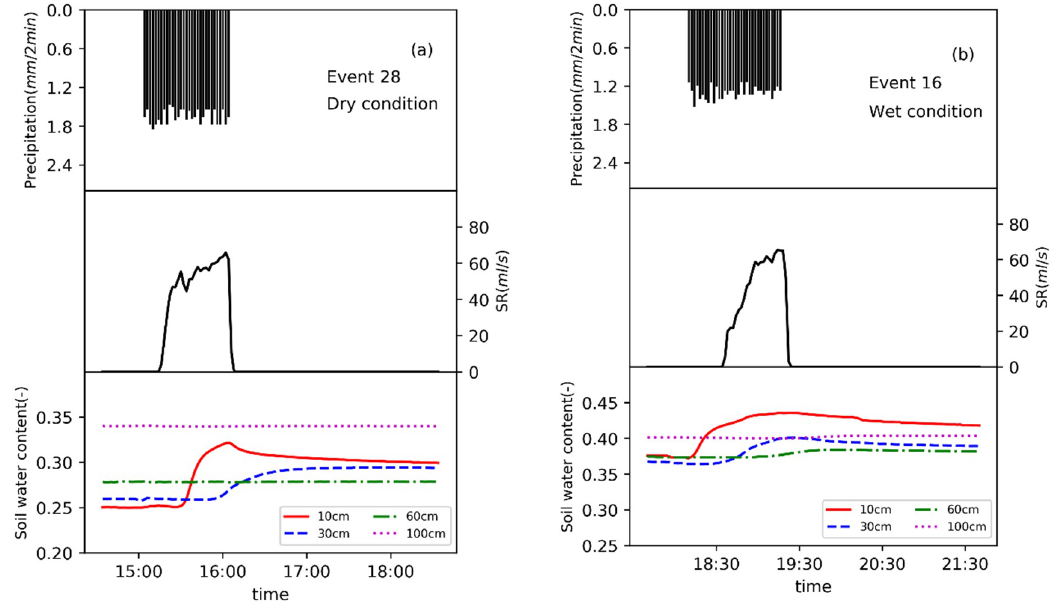
Figure 11. Two examples of the variation of rainfall, surface runoff (SR) and soil water content at soil moisture profile SM4 with selected period: ( a ) Event 28 with relatively dry initial conditions (25.1%); ( b ) Event 16 with relatively wet initial conditions (39.4%).